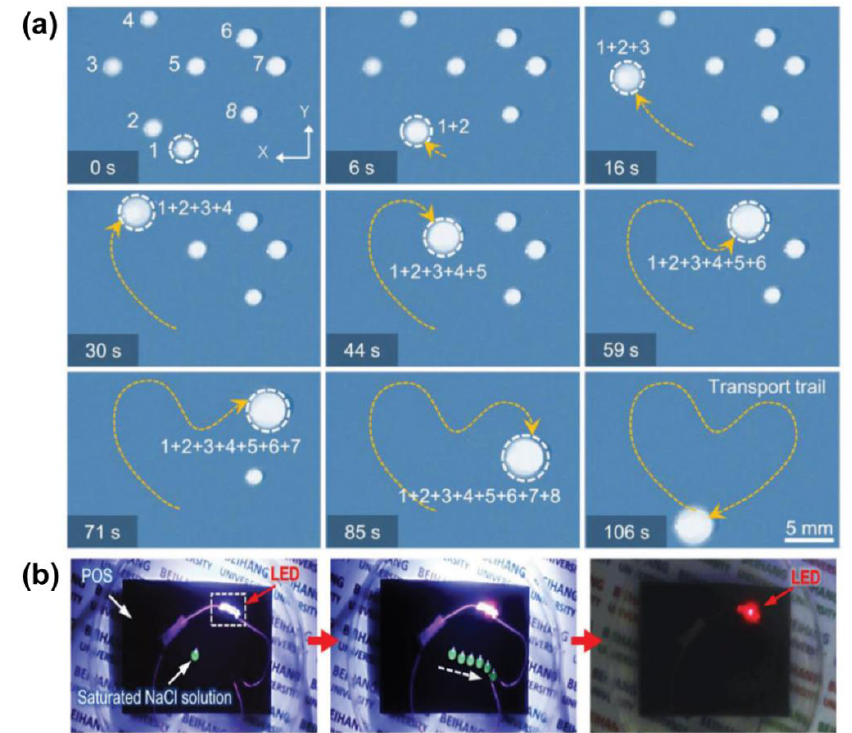
Figure 11. ( a ) Sequence of images of light-driven droplets on LIS There are eight water droplets (numbered with 1–8, the volume of each droplet varies between ≈ 3 and 5 µ L). Droplet 1 can be moved to merge sequentially with other droplets along a designed “heart”-shaped trajectory in 106 s and finally form a large droplet. ( b ) Smart light-emitting circuit of droplet transport by NIR. The open-circuit is connected once a NIR guided droplet ( ≈ 6 µ L) of saturated sodium chloride solution touches both ends of the circuit. The light-emitting diode in the circuit is turned on and gives off red light. Reprinted with permission from [40]. Copyright (2018) American Chemical Society.